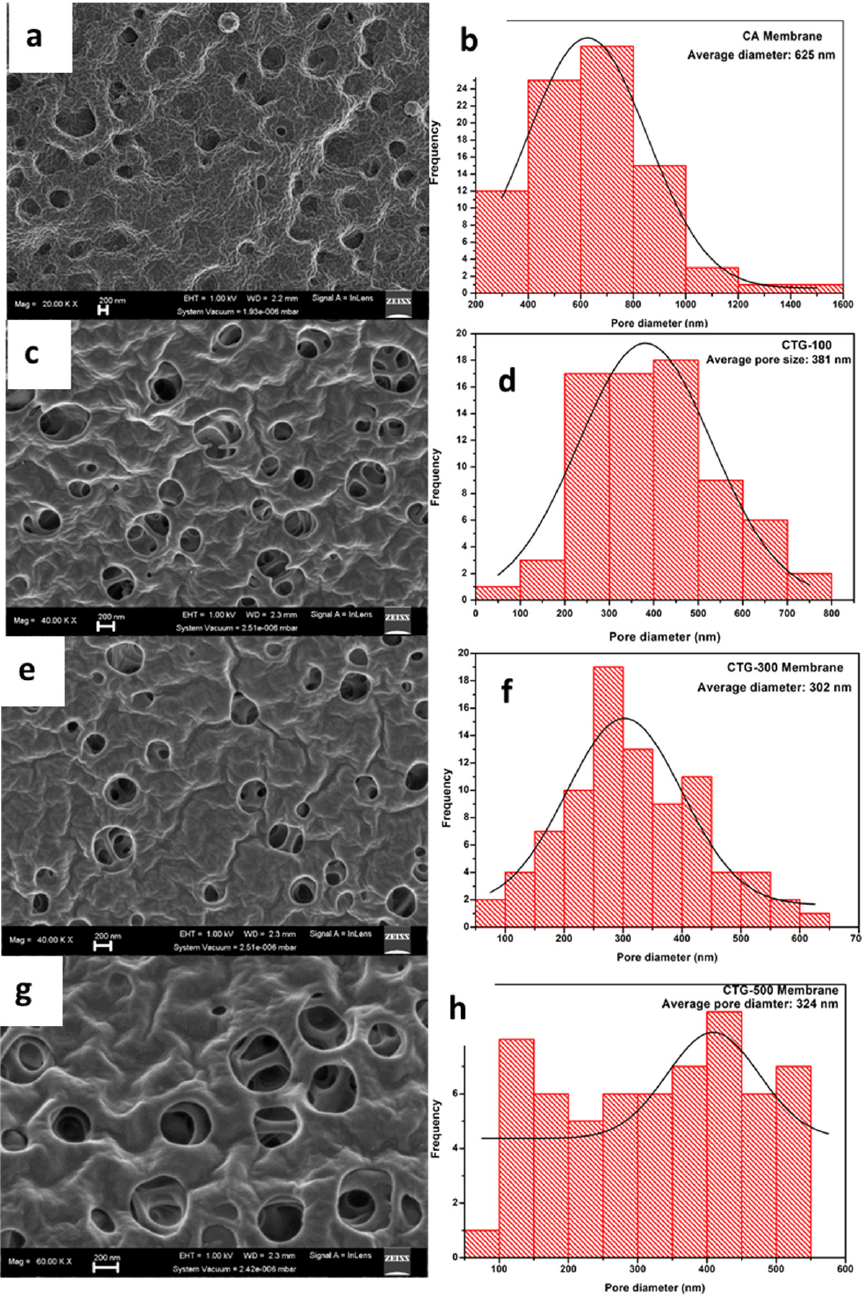
Figure 4. SEM micrographs of ( a ) neat CA, ( c ) CTG—100, ( e ) CTG—300 and ( g ) CTG—500 and their respective pore size distribution displayed in ( b , d , f , h ).